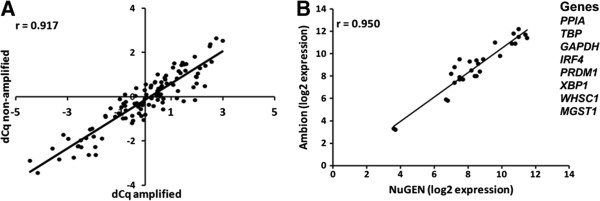
Evaluating the impact of amplification. A: Gene-specific amplification determined by qPCR. Scatter plot comparing dCq for a gene between two cell lines for non-amplified samples with dCq for the same gene and cell lines after amplification. Pearson’s correlation coefficient is r = 0.917. Genes included PPIA, TBP, GAPDH, IRF4, PRDM1, XBP1, WHSC1 and MGST1. B: Comparing NuGEN protocol to standard protocol. Scatter plot comparing the Exon expression values generated by the NuGEN protocol to expression values generated by the Ambion protocol. Genes included are PPIA, TBP, GAPDH, IRF4, PRDM1, XBP1, WHSC1, and MGST1. The Pearson’s correlation coefficient is r = 0.950.